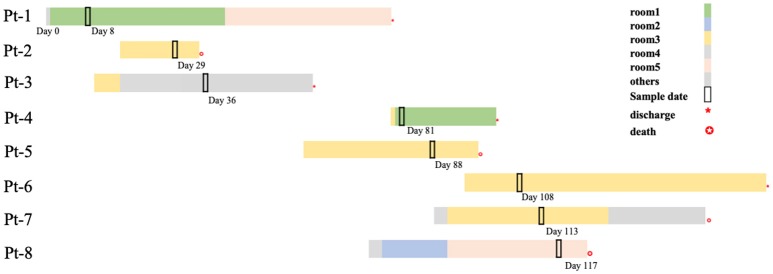
Timelines and overlap of outbreak CP-Kp isolates. Day 0 refers to the day of admission to our hospital of Pt-1. Sample days are noted nearby the black box indicating the culture-positive date.